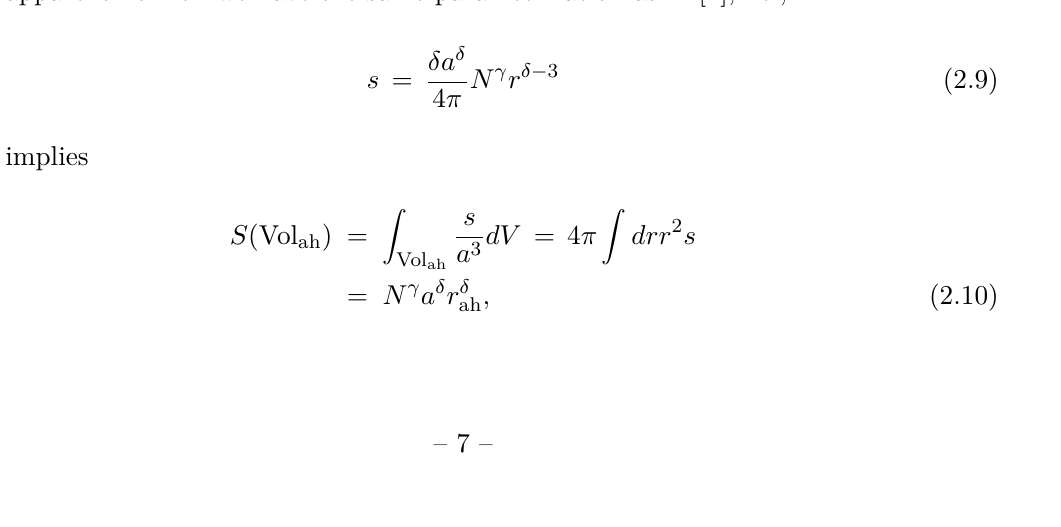
Figure 2 . Conformal Penrose diagram for a flat contracting cosmology with apparent horizon at η which is larger than r = − η . In this case, L + does not focus before the singular surface η = 0 . In fact, L + intersects part of the time evolved spacelike region inside r apparent horizon will bound the entropy on part of the volume inside it. The volume of this region is determined by how much of it L + probes before hitting the singularity, and its radial range is depicted in the figure by lines of constant r drawn in